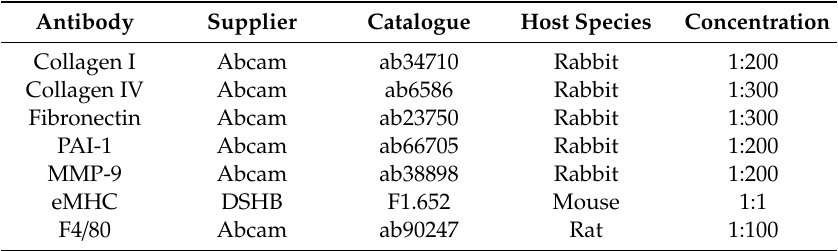
Table 1. Antibody list used for immunofluorescence. Validation is provided on supplier’s